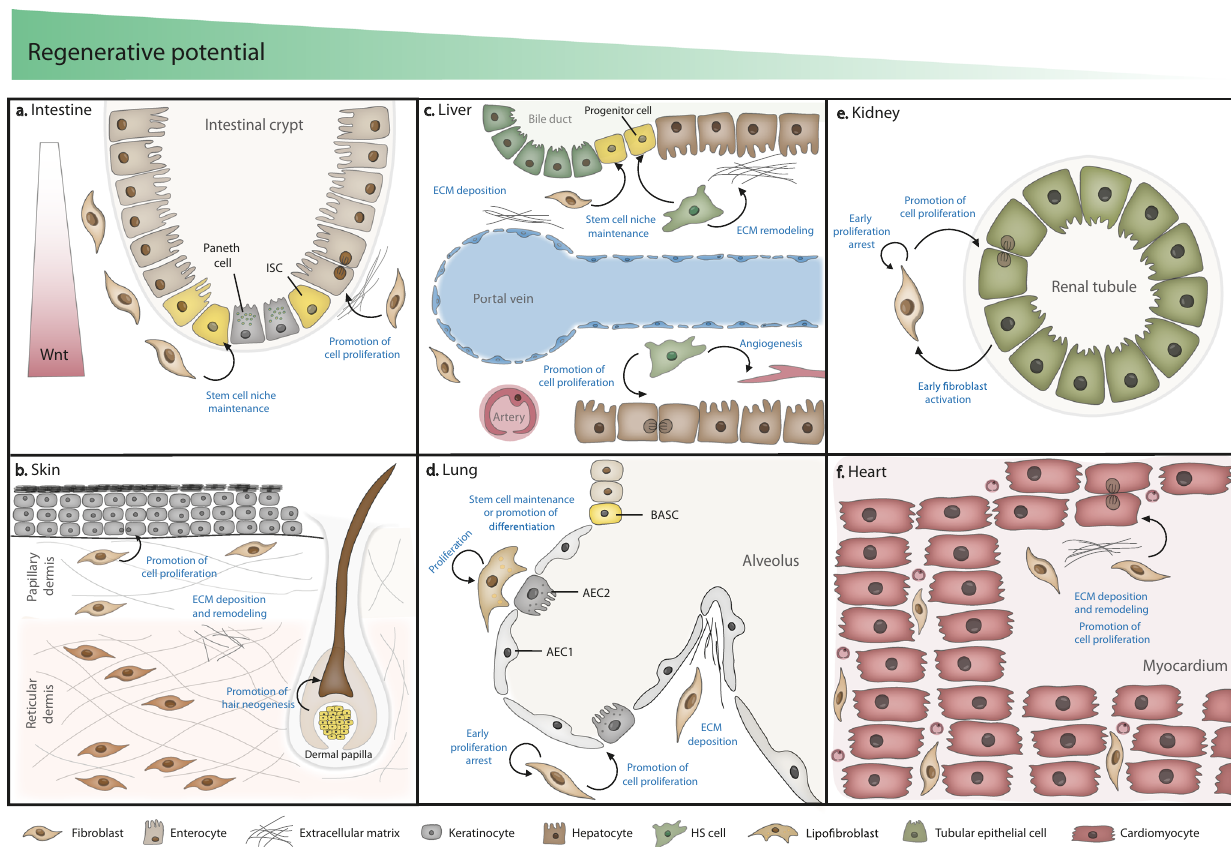
Fig. 1 The fi broblast as a mediator of regeneration in major organs. a Intestinal fi broblasts are a component of the stem cell niche, secreting ECM, growth factors, and creating a Wnt gradient along the crypt promoting ISC proliferation/differentiation. b Dermal fi broblasts promote regeneration mainly by secreting speci fi c ECM components, promoting wound healing. A specialized population of fi broblasts (dermal papilla) is also involved in hair neogenesis. c In the liver, portal fi broblasts and HS cells promote liver progenitor and hepatocyte proliferation after injury by multiple mechanisms. d Proliferative lung fi broblasts and lipo fi broblasts promote regeneration by secreting structural ECM components and stimulating AEC2 cells with mitogens. e In the kidney, fi broblasts and epithelial cells communicate in a bidirectional fashion to coordinate tubular regeneration. f Speci fi c ECM components putatively secreted by fi broblasts have been linked to cardiac regeneration in the neonatal